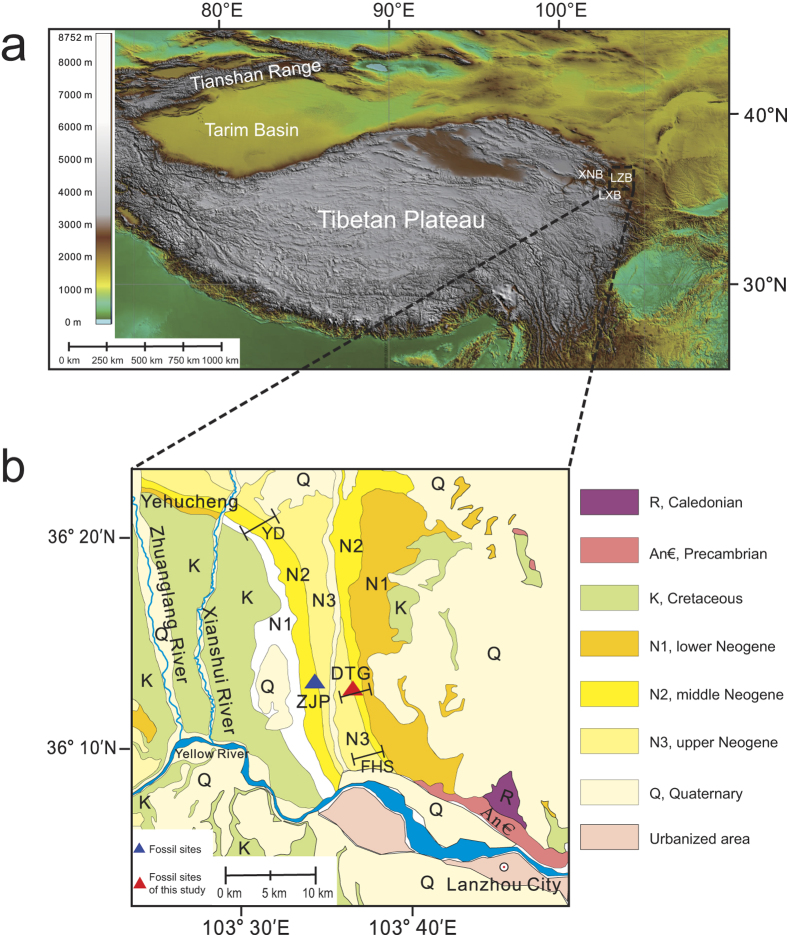
Schematic location and geologic maps showing the Tibetan Plateau and Lanzhou Basin.LXB, Linxia Basin; LZB, Lanzhou Basin; XNB, Xining Basin, YD, Yongdeng section; ZJP, Zhangjiaping Fauna; DTG, Duitinggou section; FHS, Fenghuangshan section. Maps (a) and (b) were created with QGIS version 2.0.1 (Open Source Geospatial Foundation Project, http://www.qgis.org/en/site/).